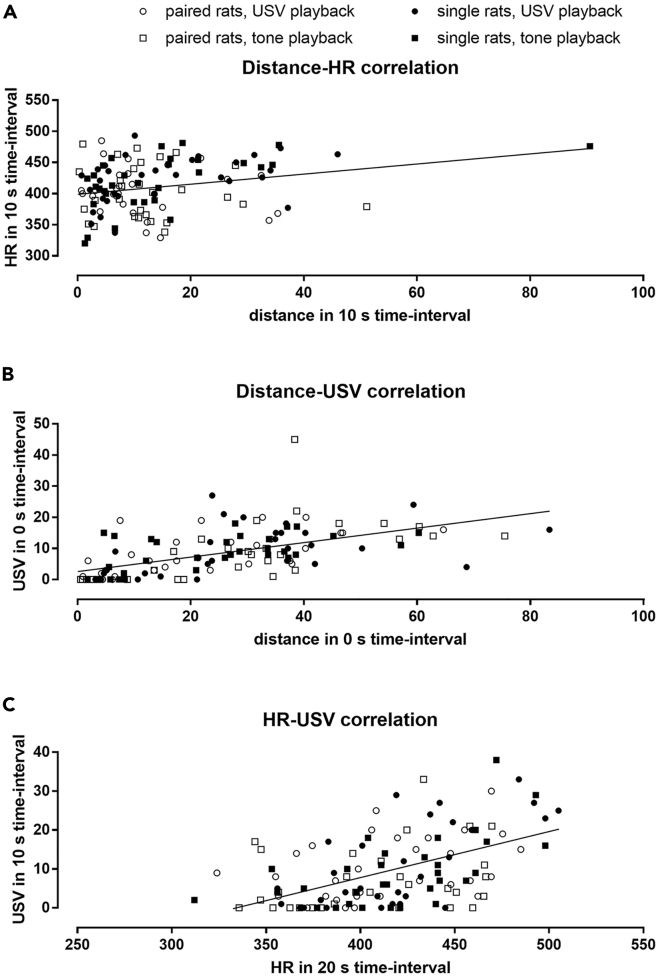
Correlations Obtained for Variables Measured in Response to 50-kHz PlaybackThe correlations are: (A) between distance traveled and heart rate (HR) during 10 s time-interval, (B) distance and number of emitted USV during 0 s interval, and (C) between HR at 20 s and number of USV at 10 s intervals. Correlations were calculated for paired (white marks) and single (black marks) rats exposed to USV (circles) or tones (squares). Straight lines represent linear regressions calculated for all four groups of results presented.For more correlations and p values, see Data S1.